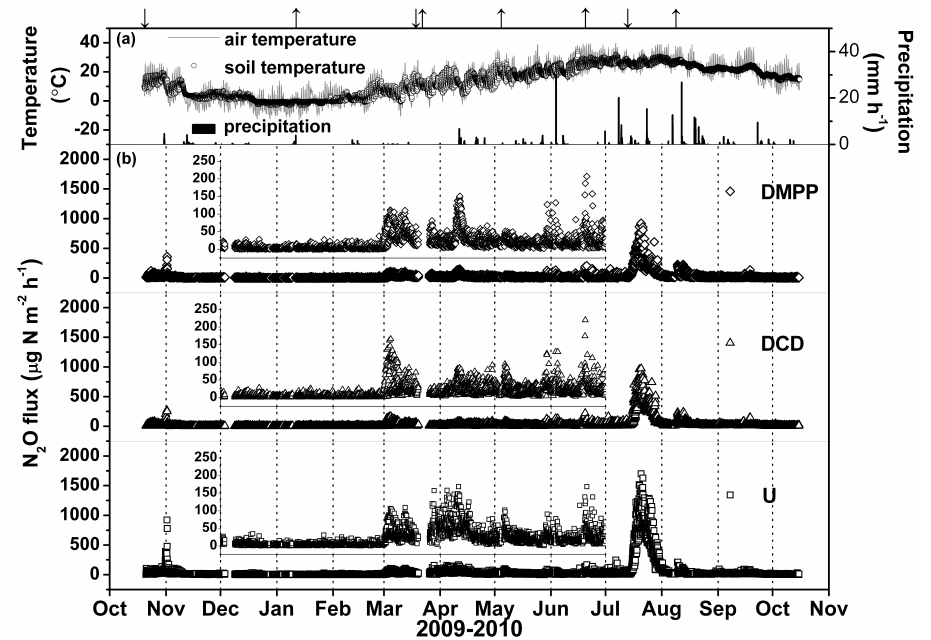
Fig. 1. Temporal courses of hourly (a) air and soil temperatures, precipitation, and (b) N 2 O flux for urea (U), urea + DCD (DCD) and urea + DMPP (DMPP) treatments. The upward ( ↑ ) and downward ( ↓ ) arrows indicate the dates of irrigation and fertilization,